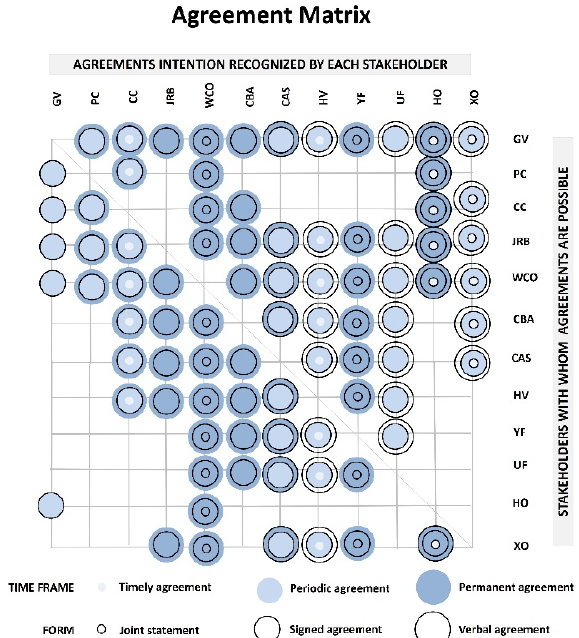
Figure 13. Time frame and form of potential agreements regarding stakeholders’ intention. Note: government officials (GV, PC, and CC that includes the 8 city councils); water managers (JRB and WCO); agricultural sector (CBA, CAS, HV, YF, UF); tourism sector (HO); environmental sector (XO).